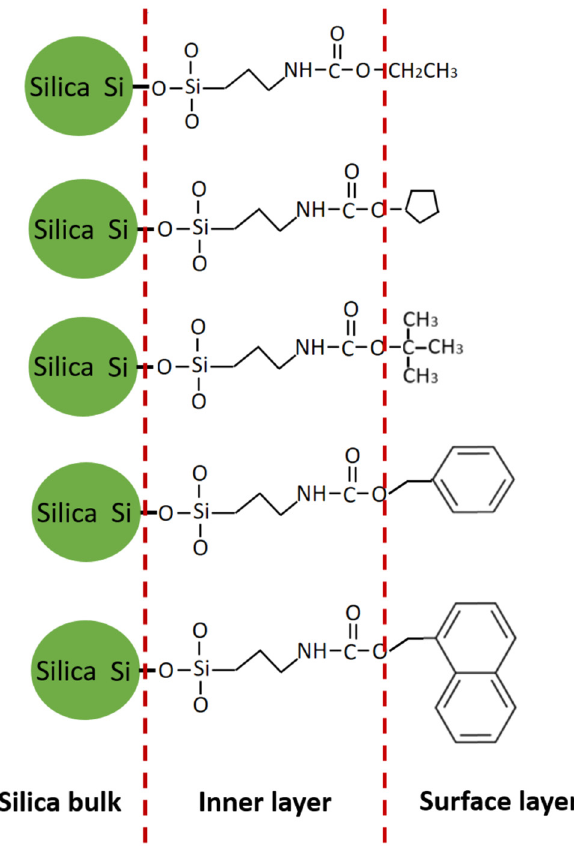
Figure 9: Chemical structure of the surface - modi fi ed